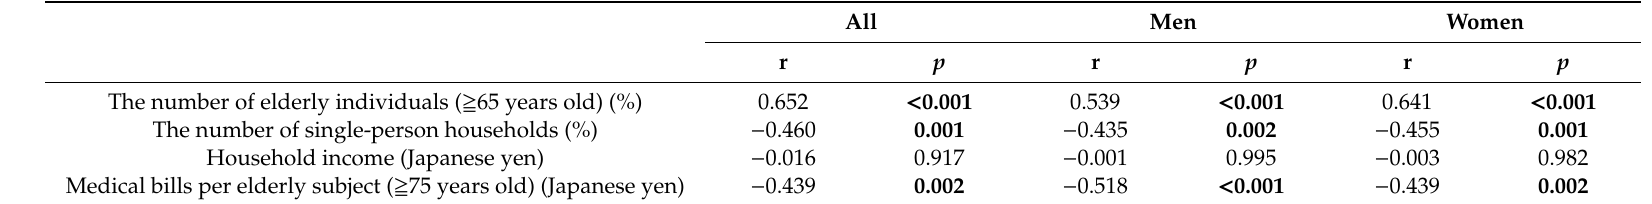
Table 3. Relationships between the number of deaths due to senility and socioeconomic factors. All Men